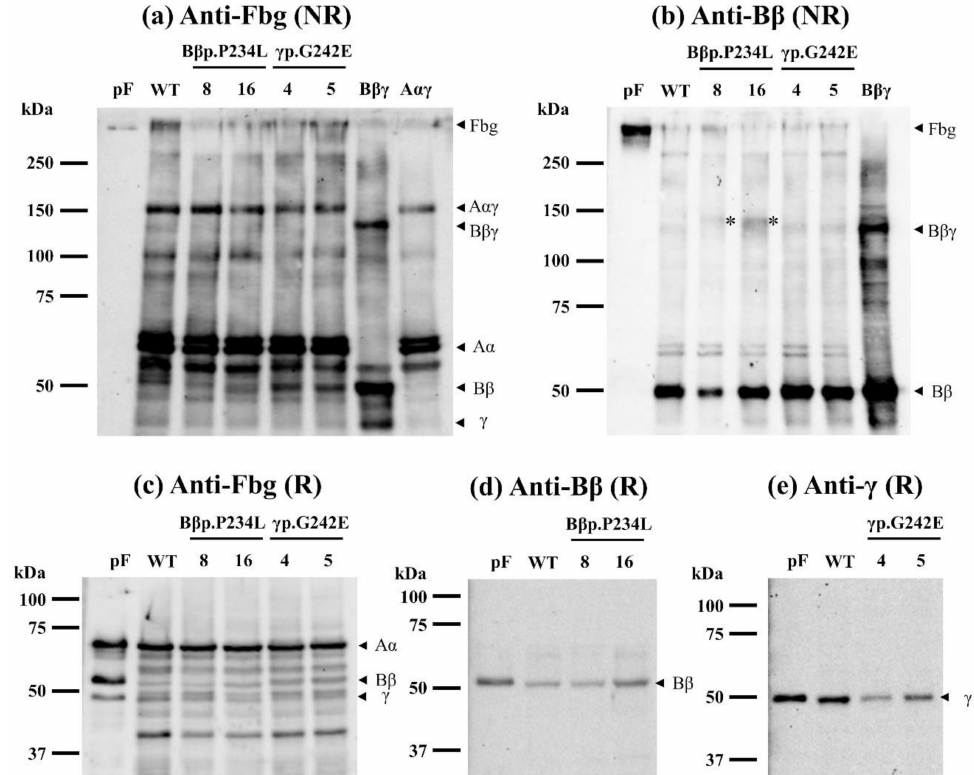
Figure 3. Immunoblotting analysis of CHO cell lysates. Panels ( a , b ) were produced in non-reducing conditions using 7.5% gels, and Panels ( c – e ) were produced in reducing conditions using 10% gels. An anti-human fibrinogen polyclonal antibody (Panel ( a , c )), an anti-human fibrinogen B β chain polyclonal antibody (Panel ( b , d )), and an anti-human fibrinogen γ chain monoclonal antibody (Panel ( e )) were used. A size marker is shown on the left side of each panel. Bands shown with an asterisk ‘*’ in Panel ( b ) indicate the migrated B βγ complex. pF: Purified recombinant wild-type fibrinogen; WT: Wild-type fibrinogen; B β p.P234L: Recombinant B β p.P234L fibrinogen; γ p.G242E: Recombinant γ p.G242E fibrinogen; B βγ : Wild-type B β and γ chains; A αγ : Wild-type A α chain and γ chain-producing CHO cell lysate. The number with each variant fibrinogen shows the clone number. NR: Non-reducing conditions; R: Reducing conditions; Fbg: